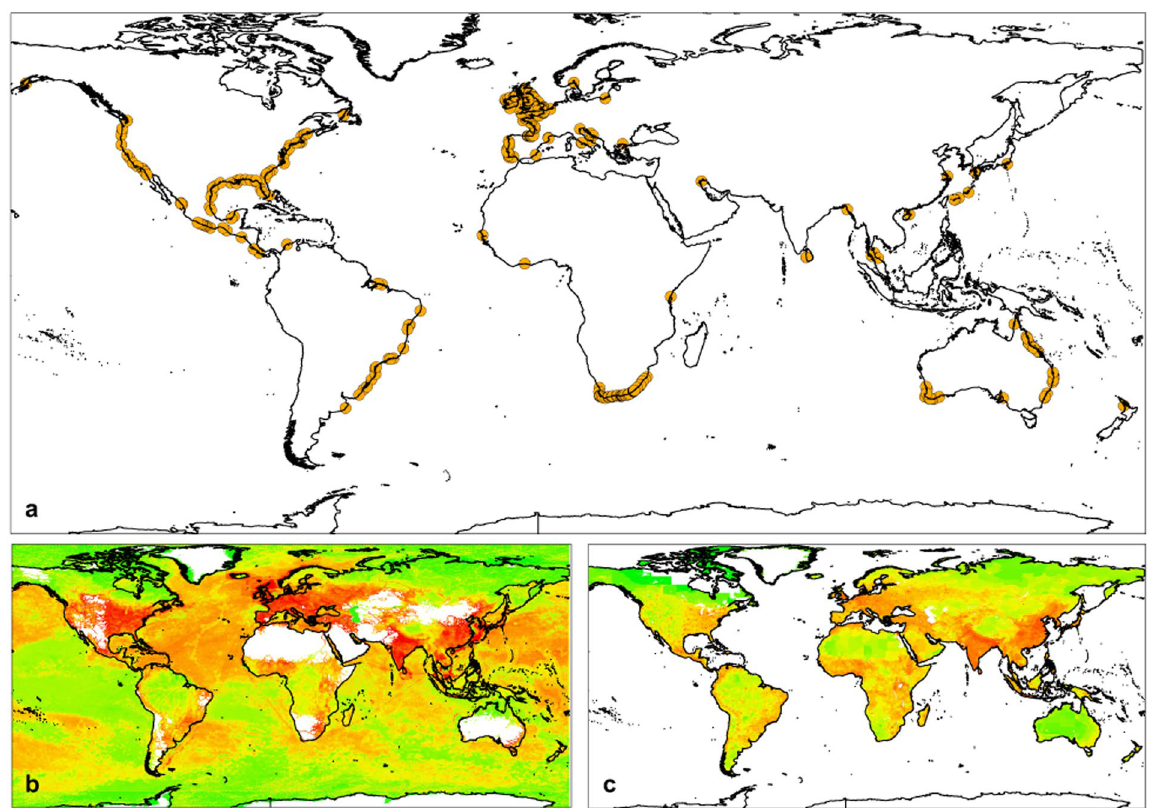
Figure 1. Location of estuaries included in the present study. The map was built in ArcGIS for desktop version 10.4 (http://desktop.arcgis.com). ( a ) Each estuary is represented with a circle (n = 530 samples and for 378 estuaries worldwide). ( b ) Intensity of human pressures in marine ecosystems [ between low (green) and high (red); data from Halpern and colleagues 12 are freely available at https://www.nceas.ucsb.edu/globalmarine/data] and in freshwater ecosystems [ between low (green) and high (red); data from Vörösmarty and colleagues 18 are freely available at http://www.riverthreat.net/]. ( c ) Human population density, which was used as intensity of human pressures in each estuary [ between low (green) and high (red); data are freely available at http://sedac. ciesin.columbia.edu/data/set/gpw-v3-population-density 63 ]. See further details in the methods